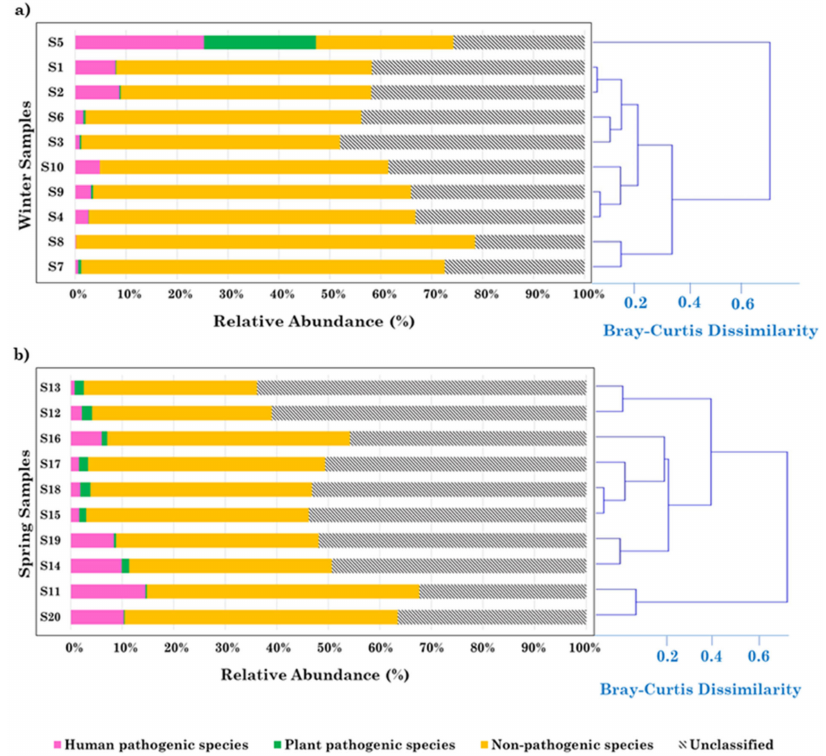
Figure 1. Relative percentage contribution of the overall amount of the 27 potential plant pathogenic species, 76 potential human pathogenic species, 1084 potential non-pathogenic species, and unclas- sified species in ( a ) winter (S1–S10) and ( b ) spring (S11–S20) samples. Bray–Curtis dissimilarity dendrograms highlighting the relatedness of the species-level bacterial communities in ( a ) winter and ( b ) spring samples have also been